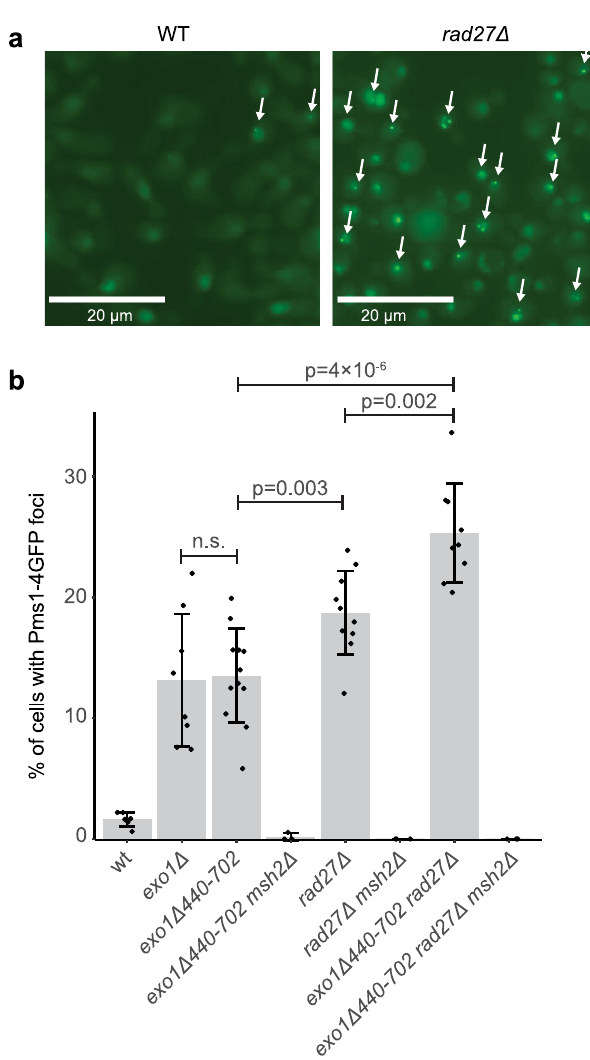
Fig. 1 Loss of Rad27 causes increased levels of Pms1 foci. a Example fl uorescence micrographs of wild-type and rad27 Δ cells expressing Pms1- 4GFP show increased levels of foci (white arrows) in the rad27 Δ cells. The bar indicates 20 μ m. b Quantitation of the average number of Pms1-4GFP foci; error bars represent the standard deviation, the bars indicate the mean of the observations, and the points show the results from each fi eld quanti fi ed. The statistical test used was a two-tailed t -test. Deletion of EXO1 or the exo1 Δ 440-702 truncation cause equivalent levels of Msh2-dependent Pms1-4GFP foci. Deletion of RAD27 causes higher levels of Msh2- dependent of Pms1-4GFP foci than the exo1 Δ 440-702 truncation, and the exo1 Δ 440-702 rad27 Δ double mutant strain has higher levels of Msh2- dependent Pms1-4GFP foci than either single mutant. The reported experiments were done twice and a minimum of 8 independent fi elds were captured and quanti fi ed per strain